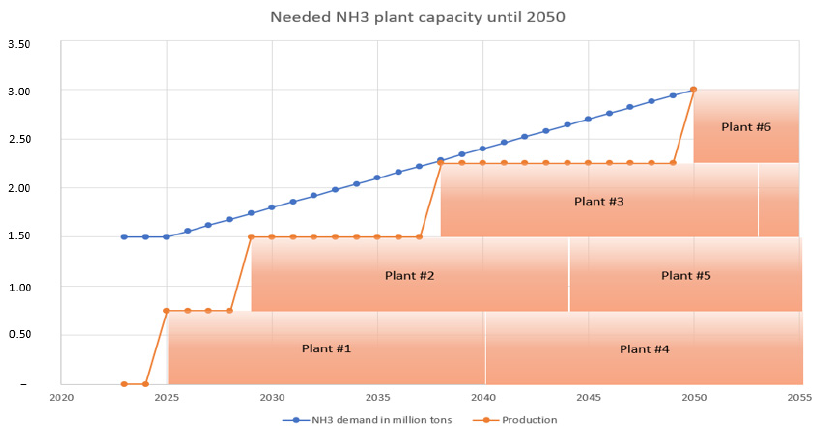
Figure 2. Ammonia-plant capacity until 2050.